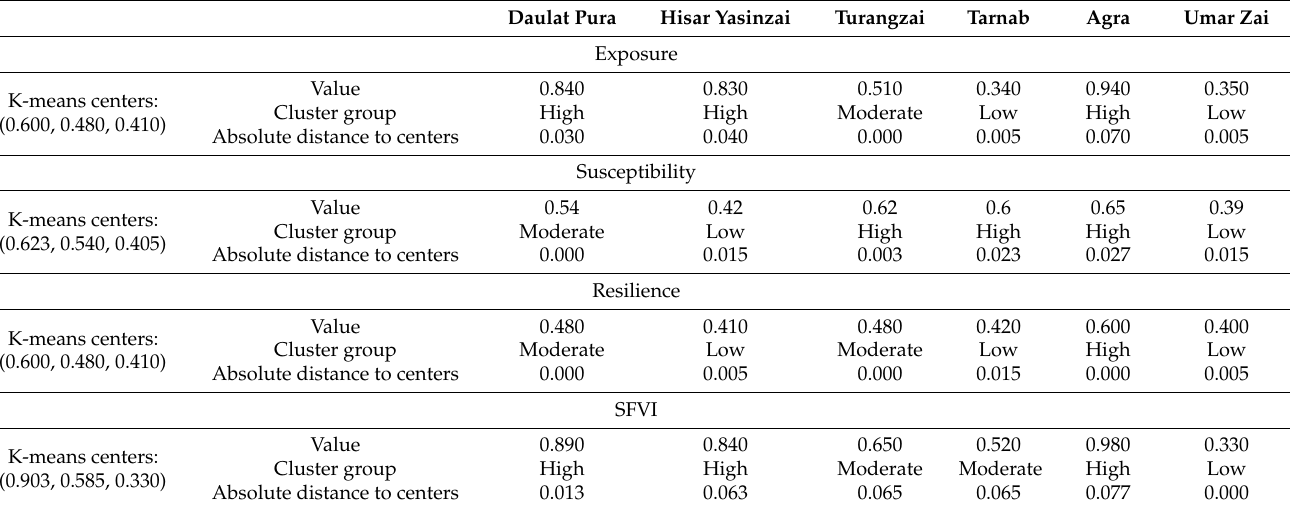
Table A1. K-means clustering results for identifying six UCs into three